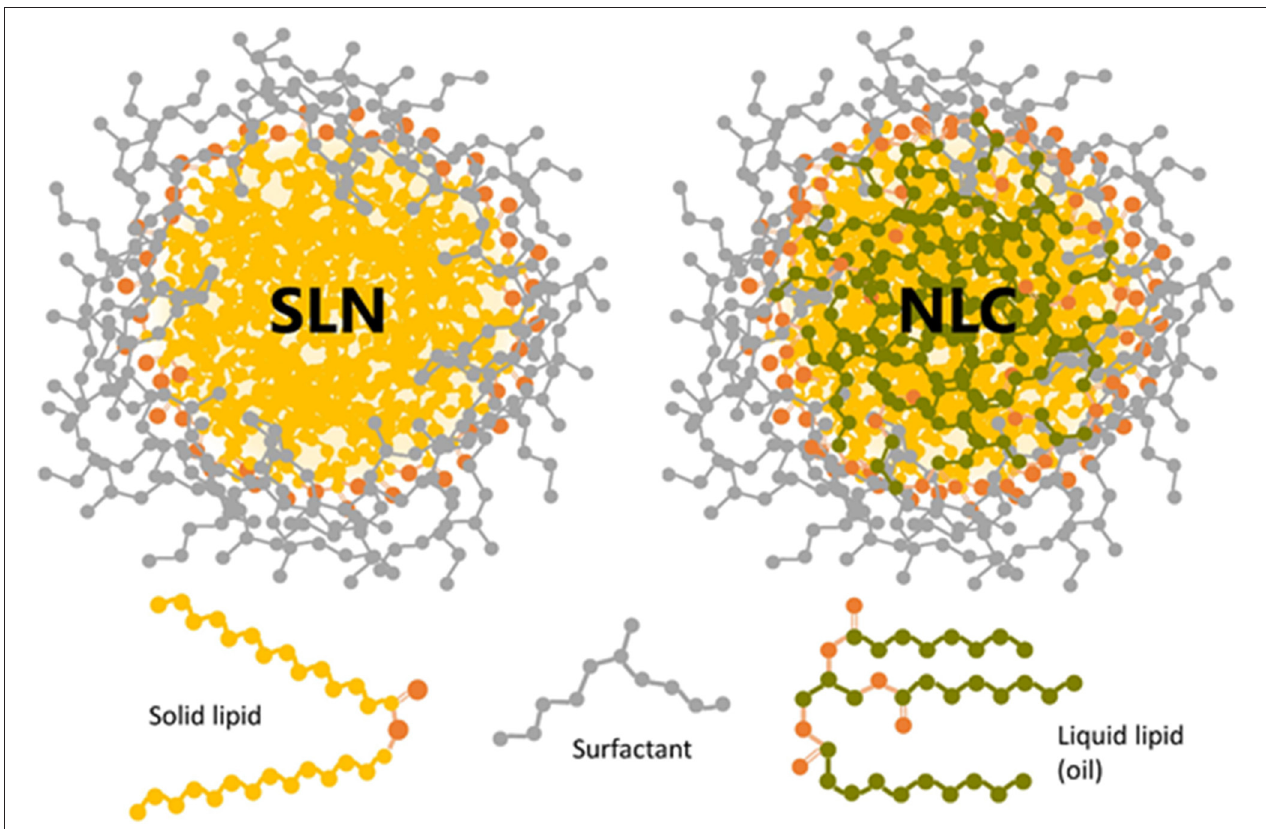
FIGURE 2 | Schematic representation of sterically stabilized NLCs and SLNs with a neutral surfactant. The oxygen atoms in solid and liquid lipids are shown in orange color. Reproduced with permission from Frontiers in Molecular Biosciences ( Montoto et al.,